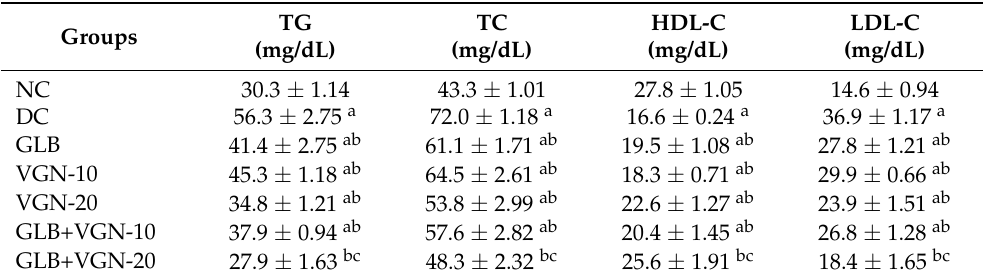
Table 4. Effect of GLB, VGN and their combinations on TG, TC, HDL-C and LDL-C levels in blood of STZ-induced rats.